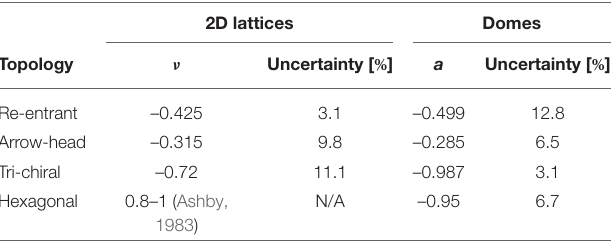
TABLE 1 | Mean values and uncertainty of the Poisson’s ratio, for 2D lattices, and of anisotropy for the domes. 2D